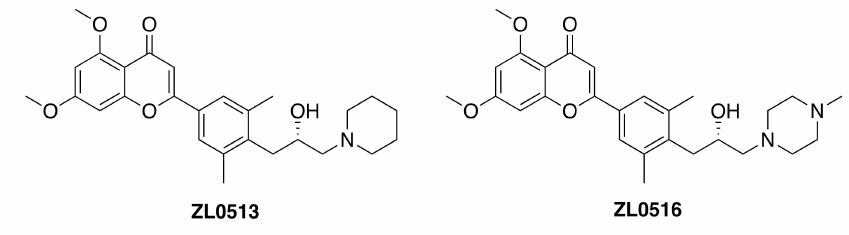
Figure 9. Structures of ZL0513 and